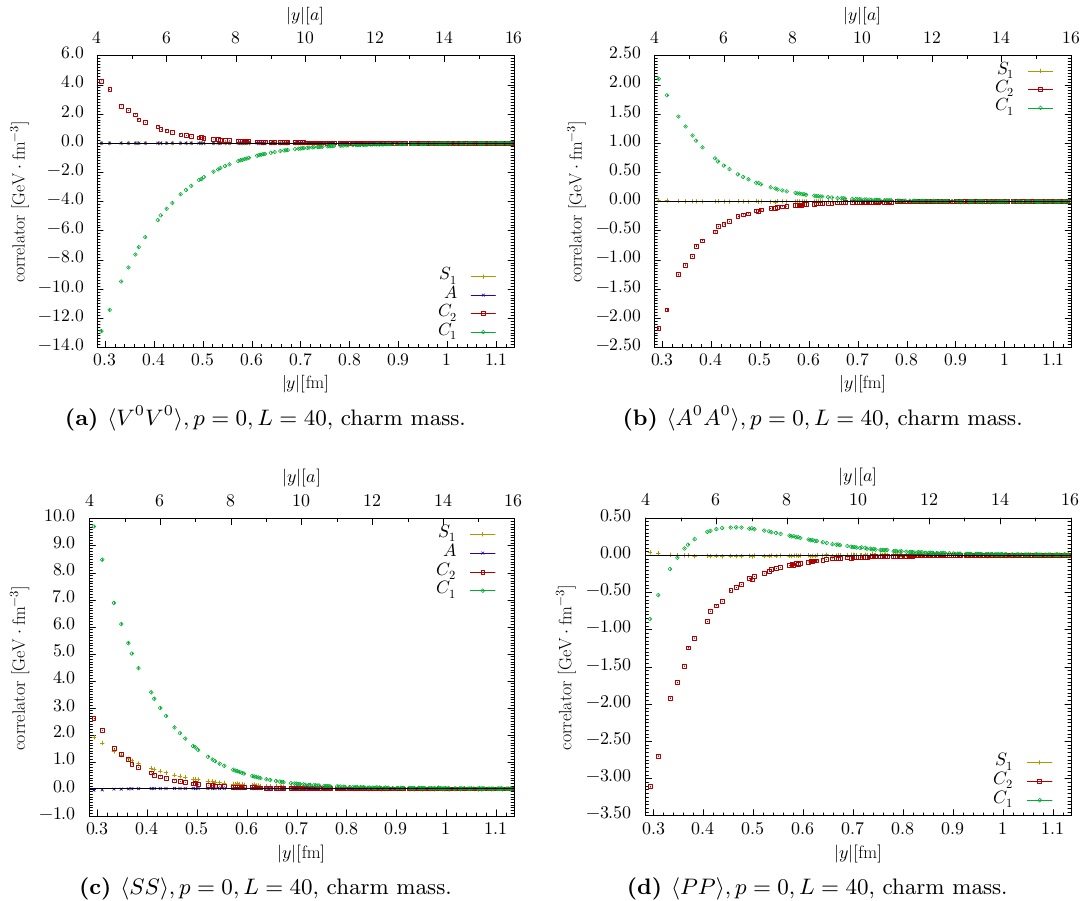
Figure 13. As (cid:12)gure 11 but for charm quarks. The contribution from the annihilation graph A is not shown for A 0 A 0 and PP , where its relatively large errors would obscure the h i h i